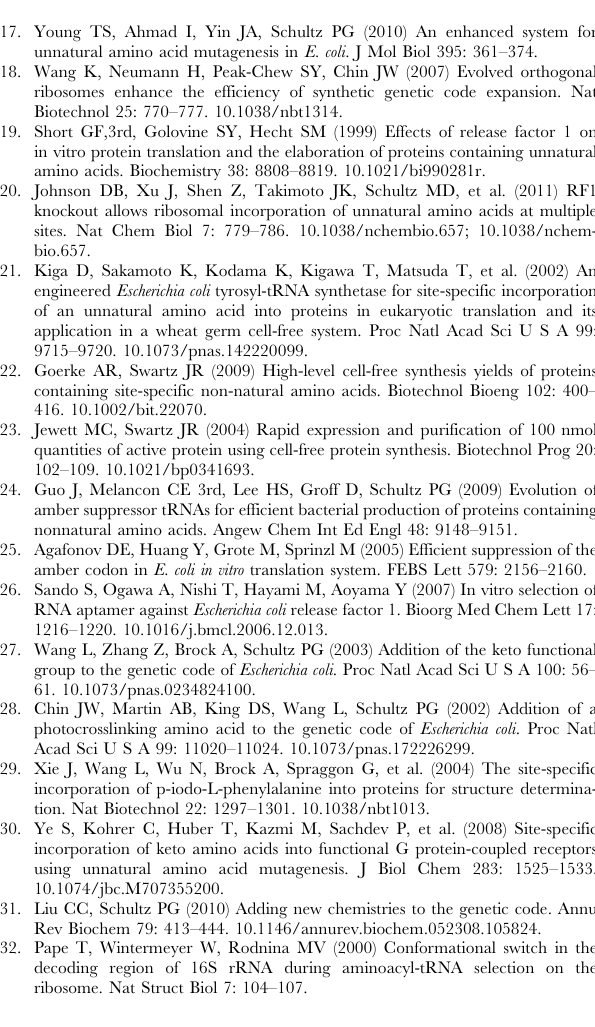
Table S1 Calculation of ‘‘y’’ and ‘‘b’’ ions of the FSVSGEGEGDATY*GK fragment (Y* denotes either tyrosine in WT GFP or UAA in the GFP Y39TAG mutants). Masses for the WT GFP-derived FSVSGEGEGDA- TY*GK peptide fragmentation were predicted by the MS-Product software of the ProteinProspector web service, while masses for GFP Y39TAG mutants were adjusted